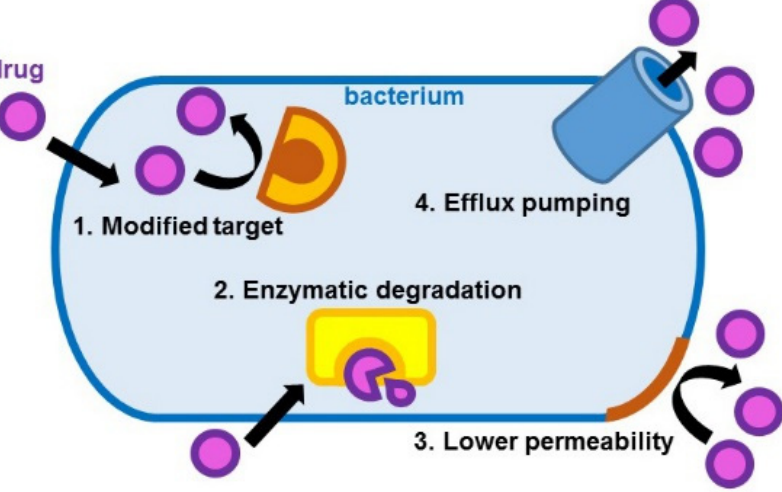
Figure 1. AMR emergence through four mechanisms.